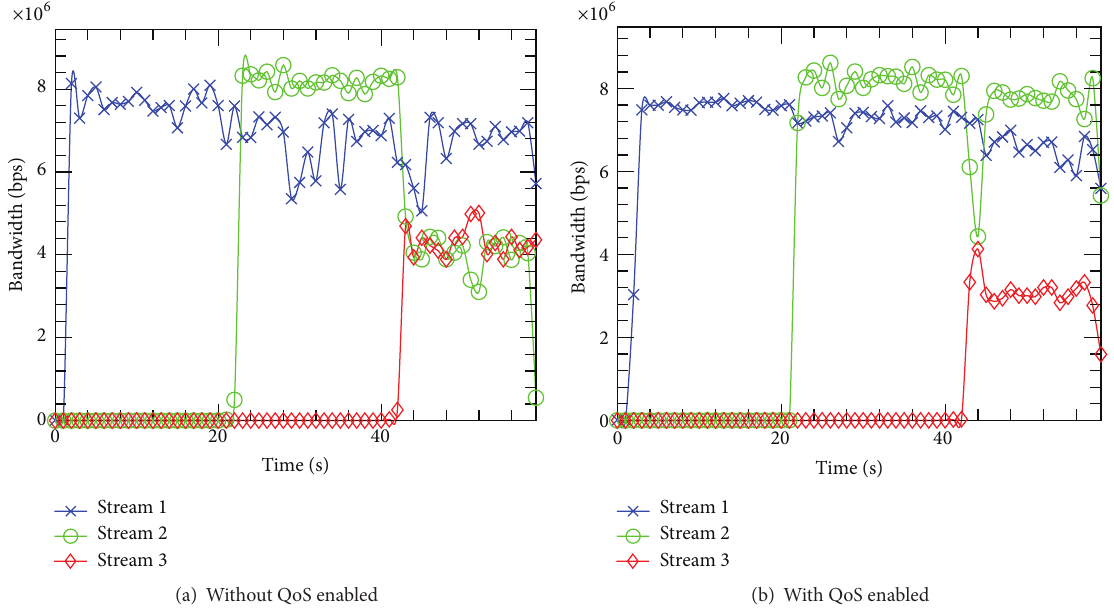
Figure 13: Conflict evaluation with and without QoSiLAN QoS enabled.